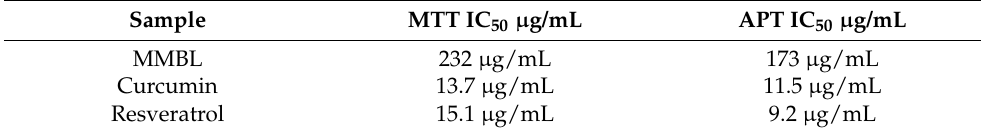
Figure 2. Analysis of percentage of MCF ‐ 7 cell death by acid phosphatase assay at different doses of (A ) Curcumin, (B ) Resveratrol, and (C ) MMBL after 48h of incubation. Each value represents a